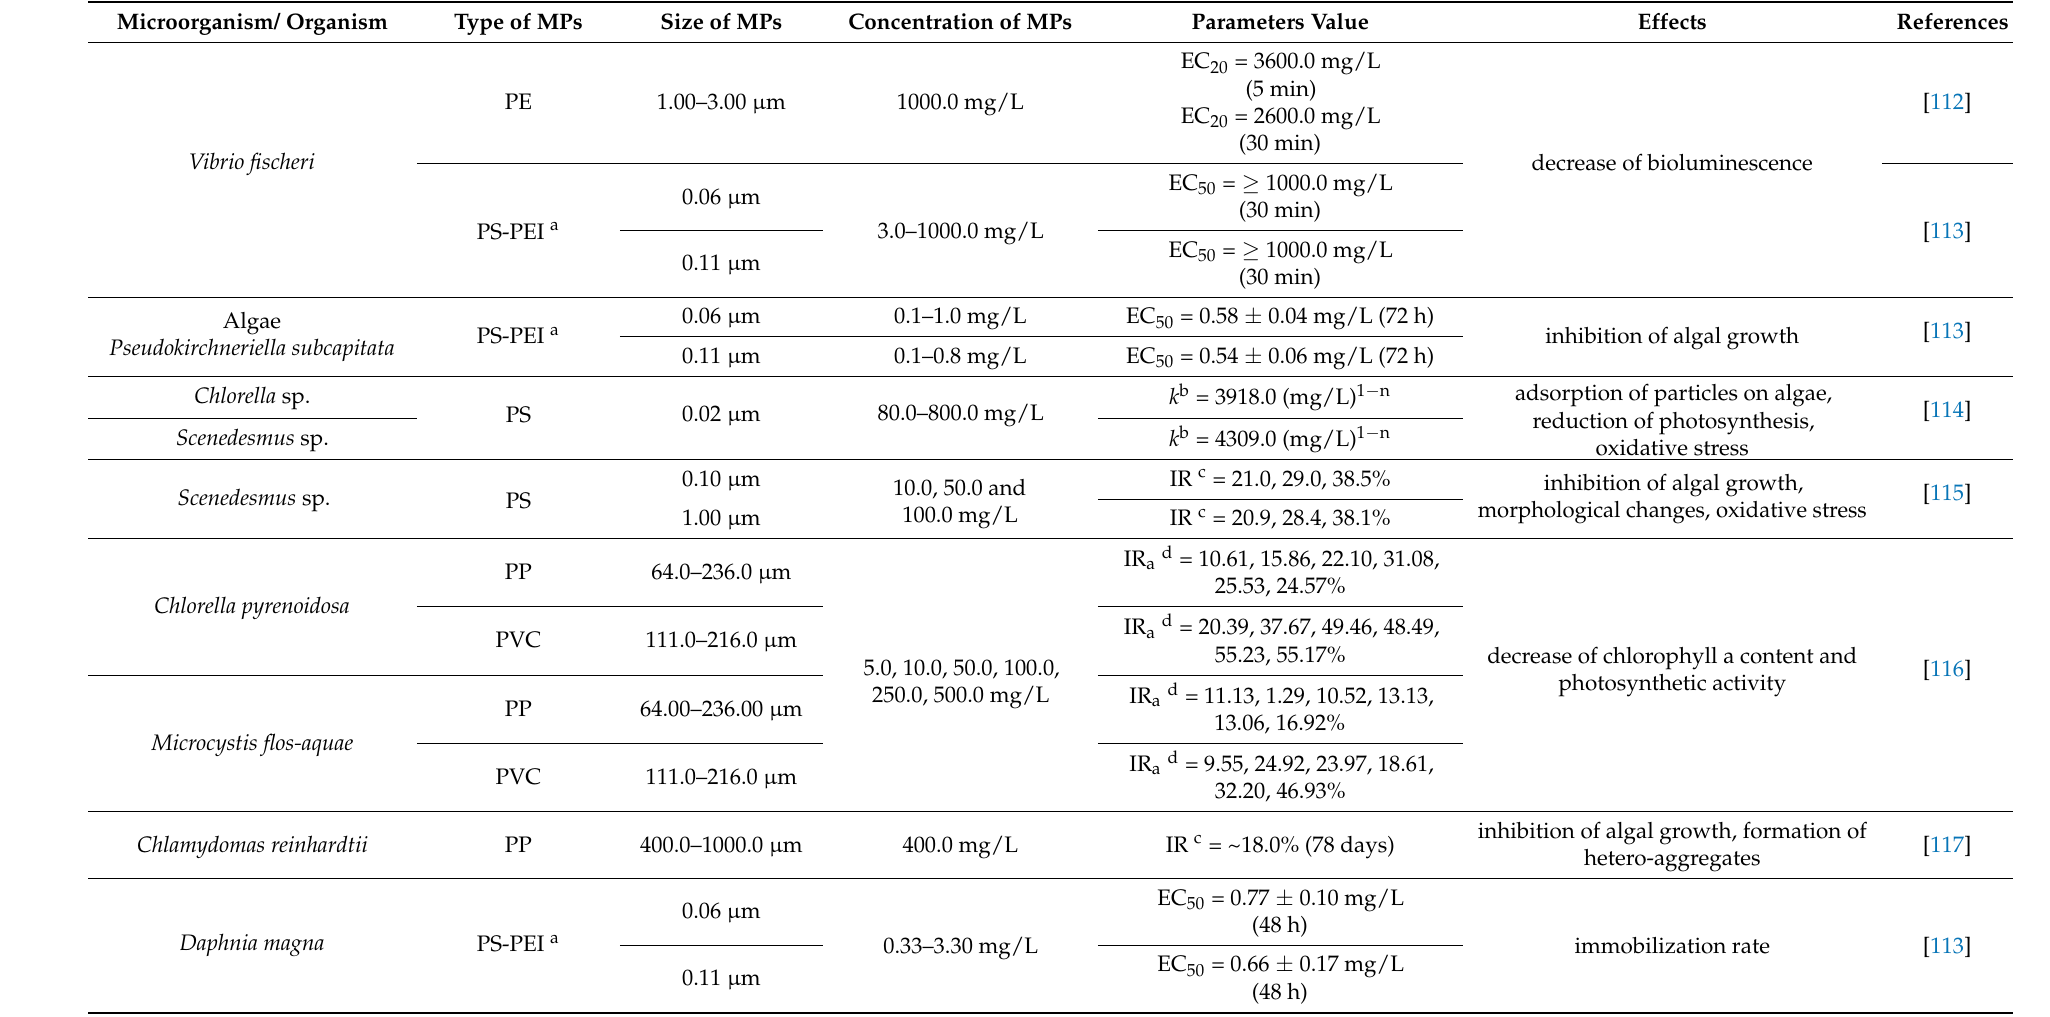
Table 3. Parameters given by different ecotoxicological